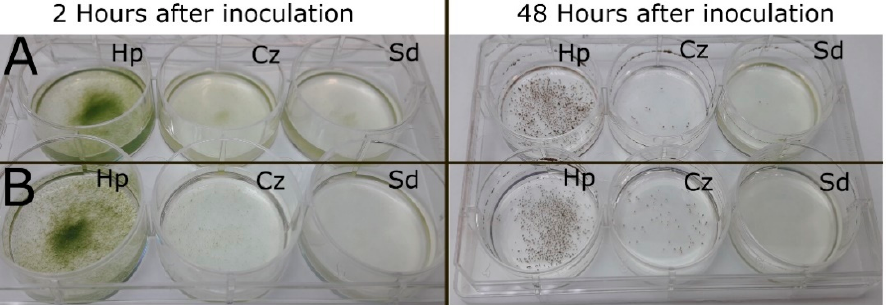
Figure 3. Virulence of purified propagules isolated from P. sedebokerense culture 2 and 48 h after inoculation. ( A ) Algal monocultures inoculated at a propagule/host cell ratio of 1:1 to allow compar- isons of prevalence and intensity of infection between microalgal species. ( B ) Algal monocultures inoculated with the same number of propagules at ratios of 10:1 Ps-Hp, 4:1 Ps-Sd and 1:1 Ps-Cz, adjusted to show similar algal surface area, to allow comparison of propagule survival and propagule production between microalgal species. Hp: H. pluvialis , Cz: C. zofingiensis and Sd: S. dimorphus